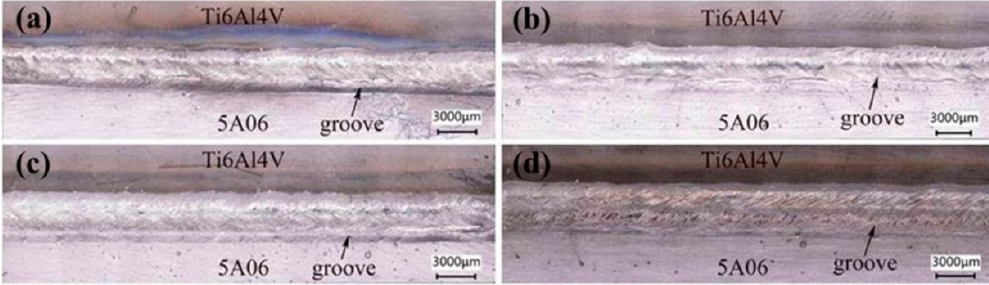
Figure 5. Influence of laser offset on weld seam appearance: ( a ) 300 μ m; ( b ) 400 μ m; ( c ) 500 μ m; ( d ) 600 μ m.